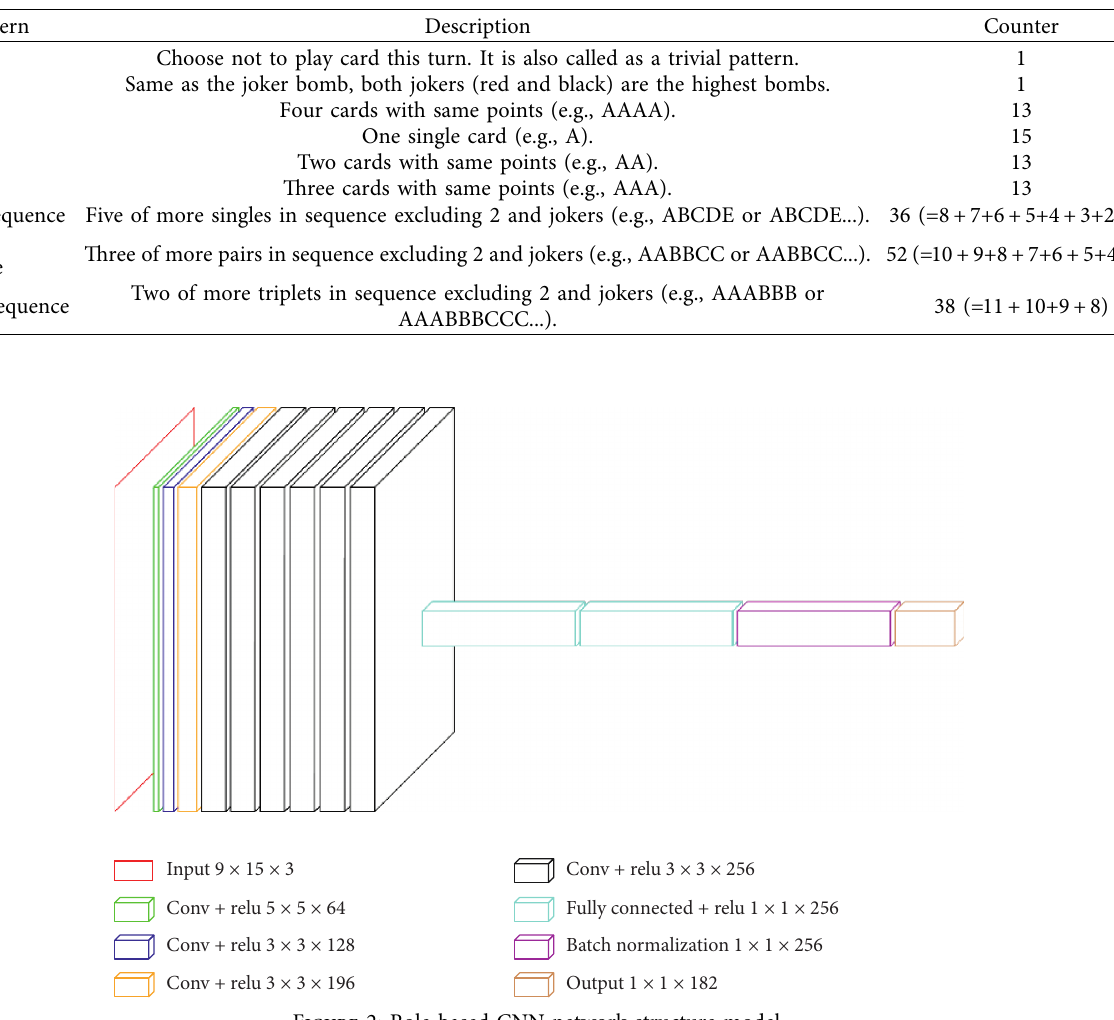
Table 1: List of ways to play cards.